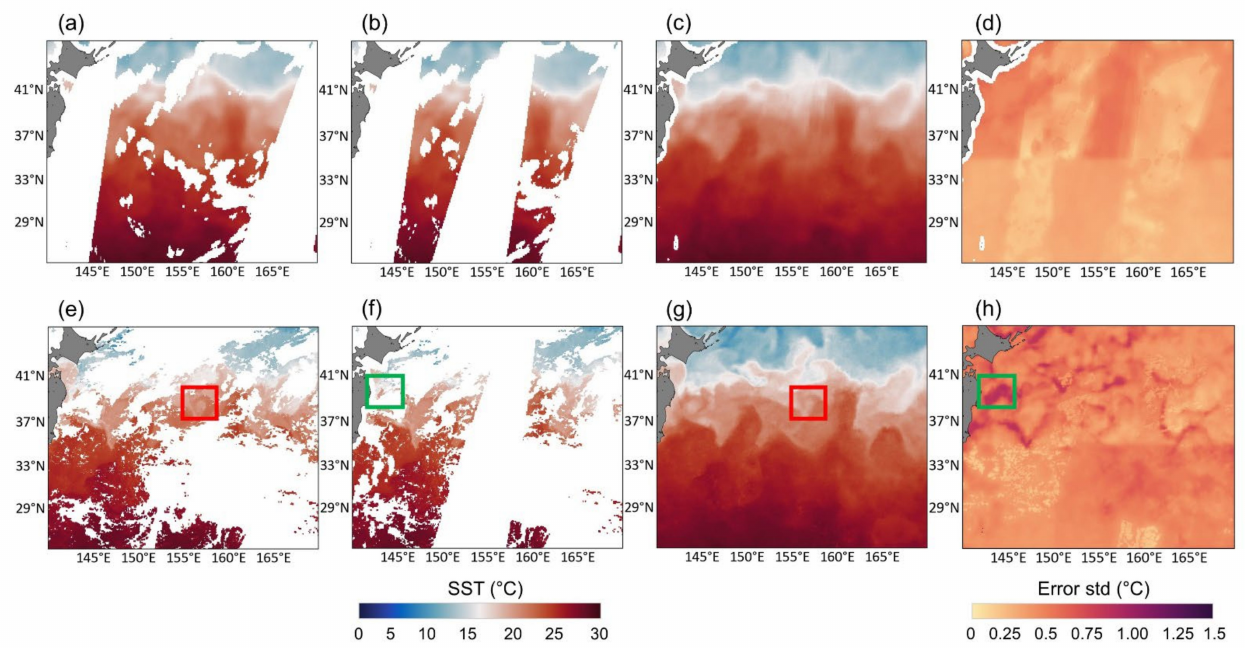
Figure 6. ( a ) Original AMSR2 SST, ( b ) original AMSR2 SST with the occlusion mask for validation, ( c ) reconstructed AMSR2 SST, ( d ) estimated error standard deviation of the AMSR2 reconstruction model, ( e ) original MODIS SST, ( f ) original MODIS SST with the occlusion mask for validation, ( g ) reconstructed MODIS SST, and ( h ) estimated error standard deviation of the MODIS